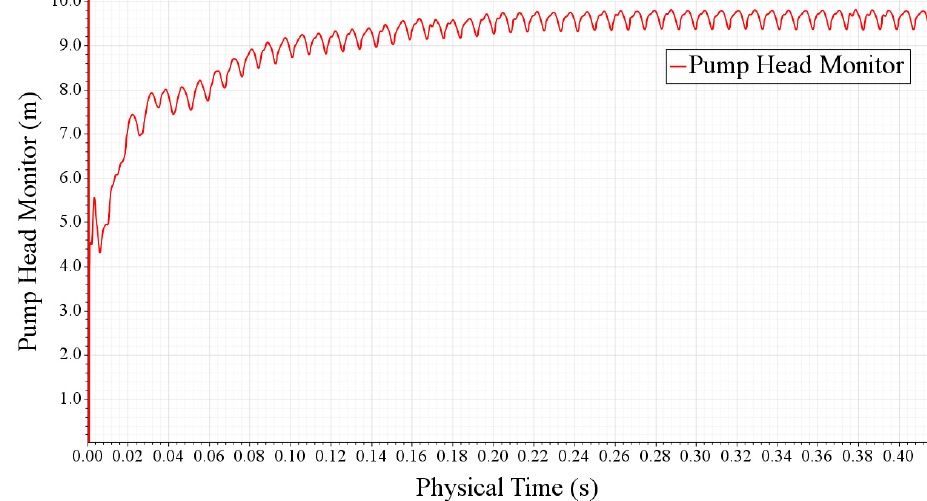
Figure 3. Variations in pump head for the sphere particle condition.